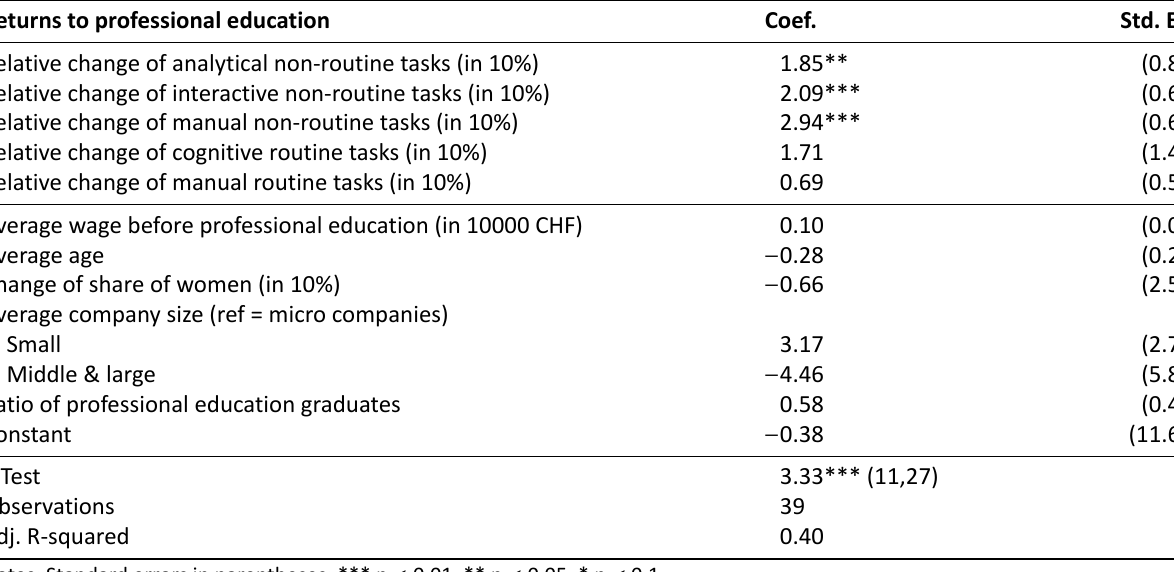
Table 3. Model II—Results of (weighted) OLS